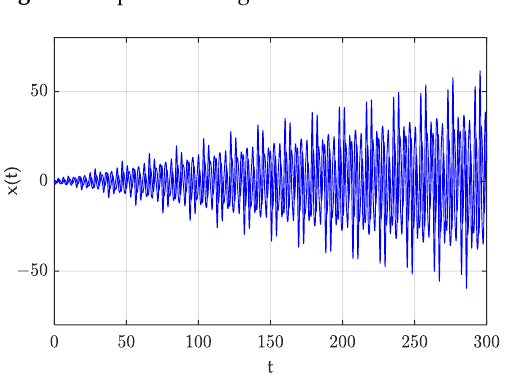
.. x + ( δ + 2 ε cos2 t ) x = F cos ( t /3 ) with ( δ = 3 , ε = 1 ).